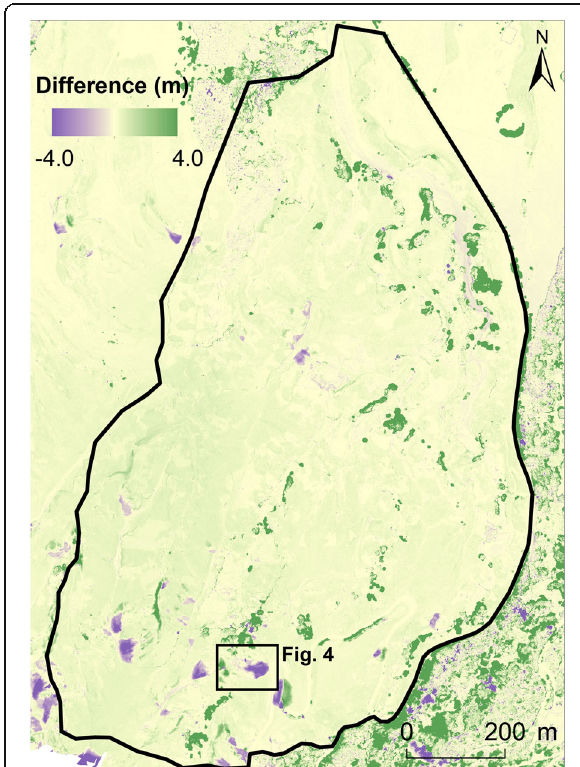
Fig. 6 Difference of digital surface models (DSMs) between May and March 2016. Blue represents a decrease in DSM caused by coseismic landslides, whereas green represents sedimentation of landslides along channels, increased grass growth, or leafing of deciduous trees. Details in the black rectangle are shown in Fig. 4. The black polygon shows the study area